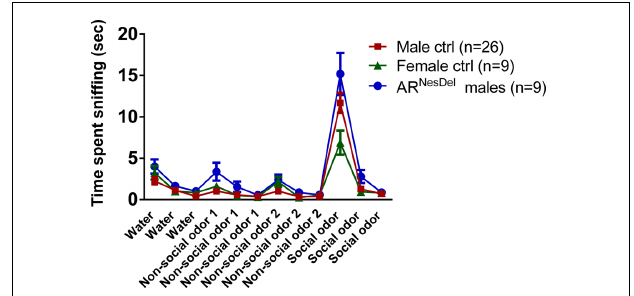
FIGURE 5 | Odor habituation/dishabituation in AR NesDel males, male controls (wildtype, AR flox , NesCre + / − ), and female controls (ARflox + / − ). Data points represent mean ± SEM.